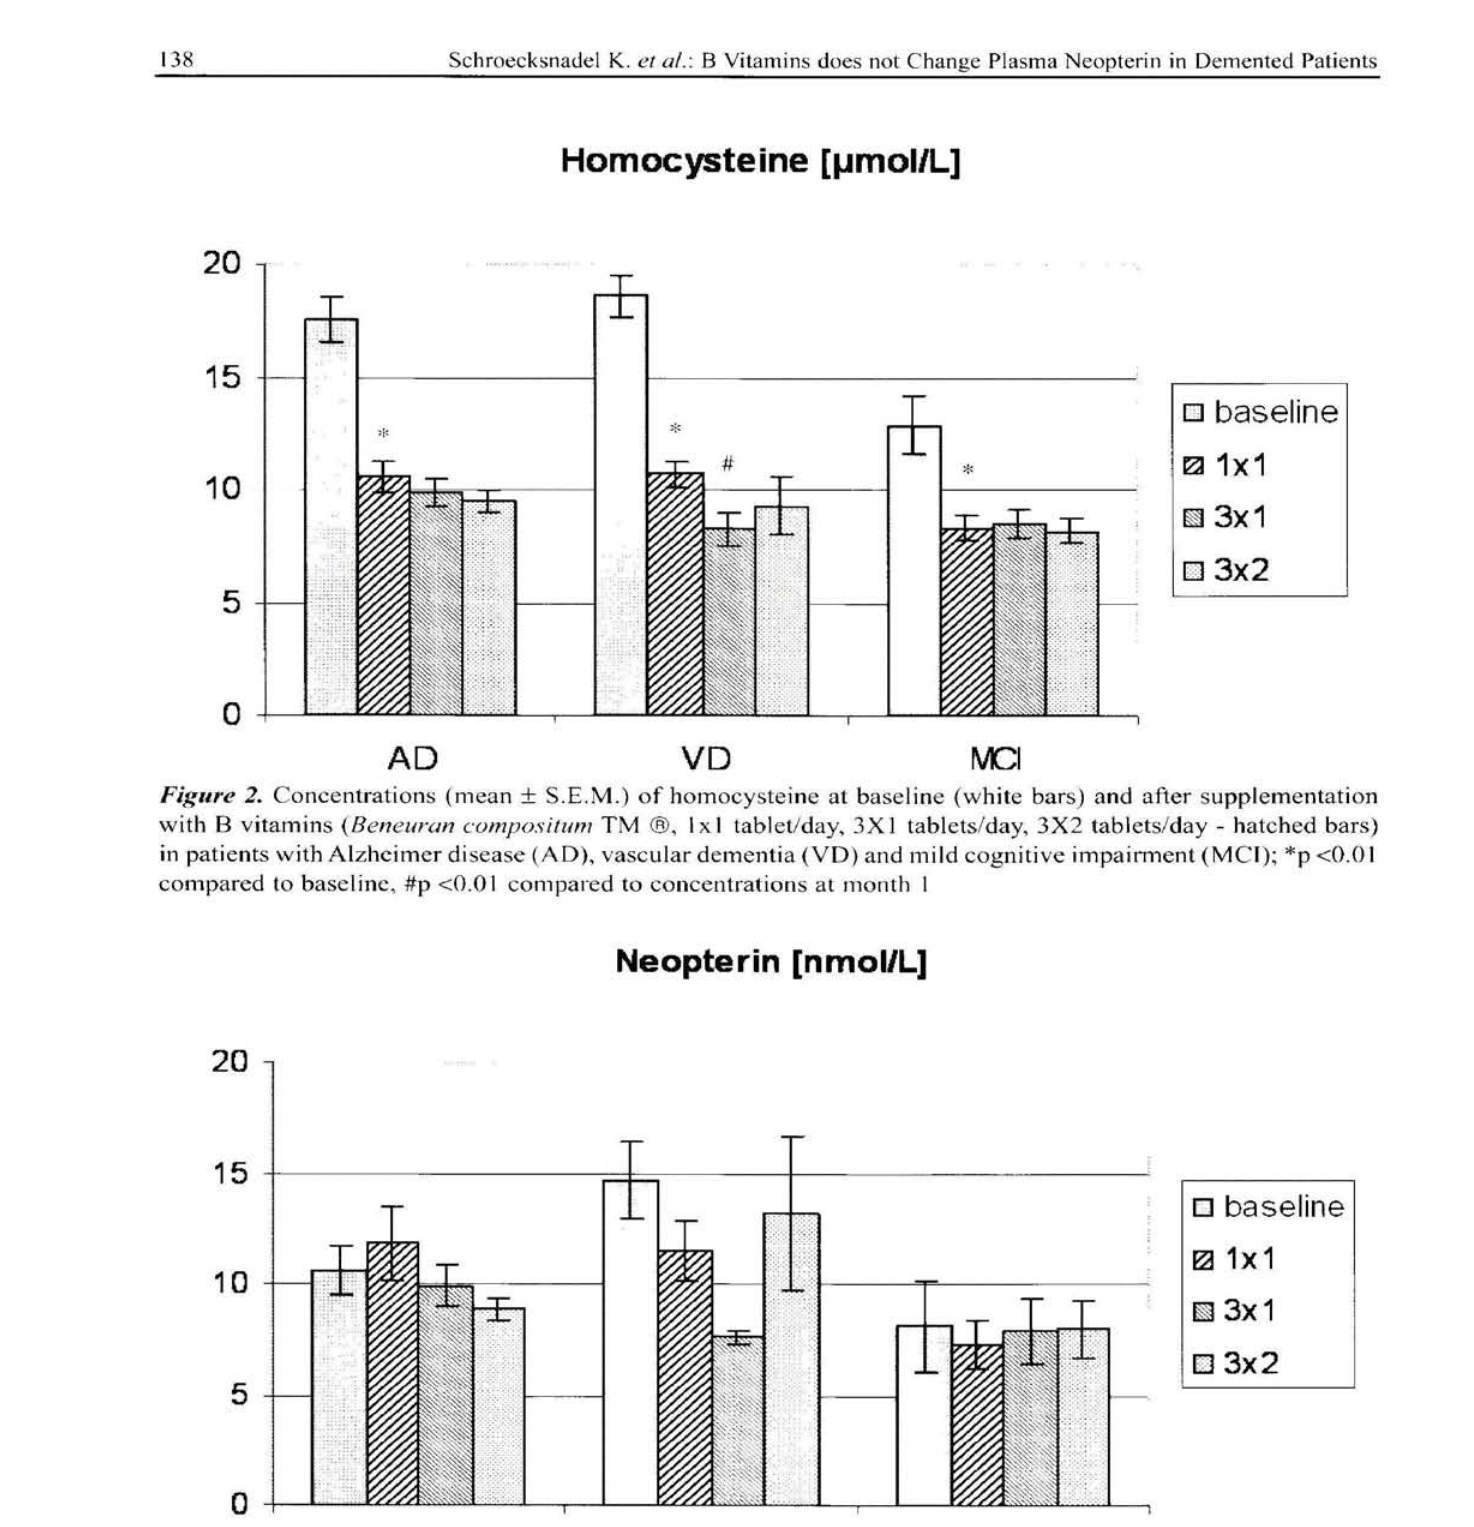
Figure 3. Concentrations (mean ± S.E.M.) of and neopterin at baseline (white bars) and after supplementation with Β vitamins ( Beneuran compositum TM lxl tablet/day, 3X1 tablets/day, 3X2 tablets/day - hatched bars) in patients with Alzheimer disease (AD), vascular dementia (VD) and mild cognitive impairment (MCI);